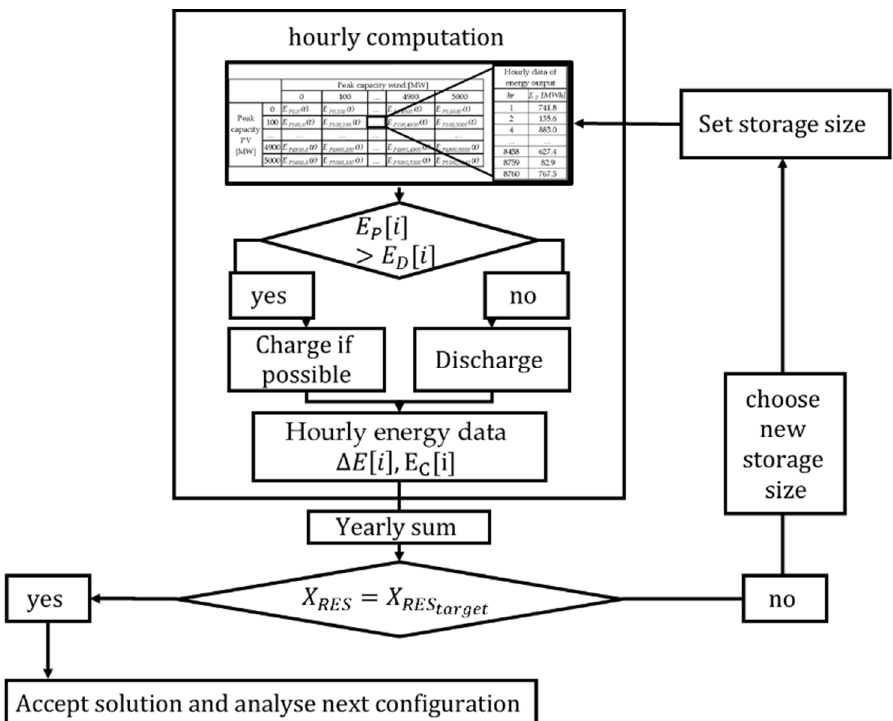
Figure 3 . Logic diagram describing the algorithm used to optimize the size the storage for each target value of renewable share: 𝑋 (cid:3019)(cid:3006)(cid:3020) , where 𝐸 (cid:3030) is the energy from the generation system that (cid:3295)(cid:3276)(cid:3293)(cid:3282)(cid:3280)(cid:3295) is consumed by the industrial process. The increments in storage size are progressively refined us- ing